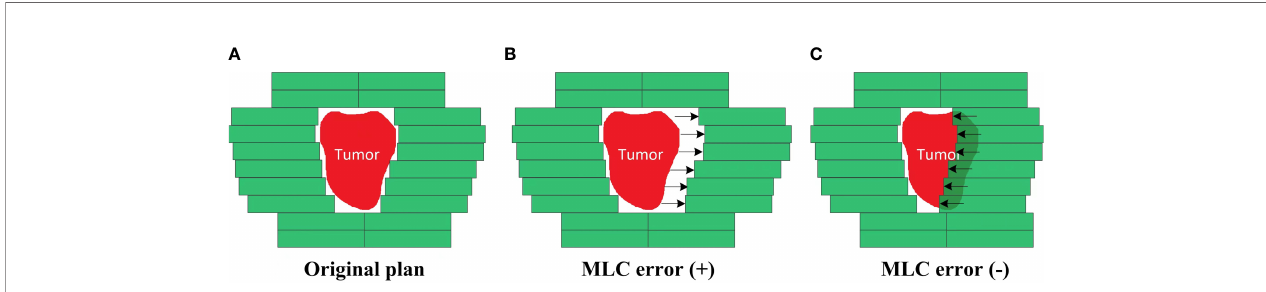
FIGURE 2 | Creation of the MLC error-introduced IMRT plan. (A) Original plan. (B) Plan introduced with positive MLC errors. (C) Plan introduced with negative